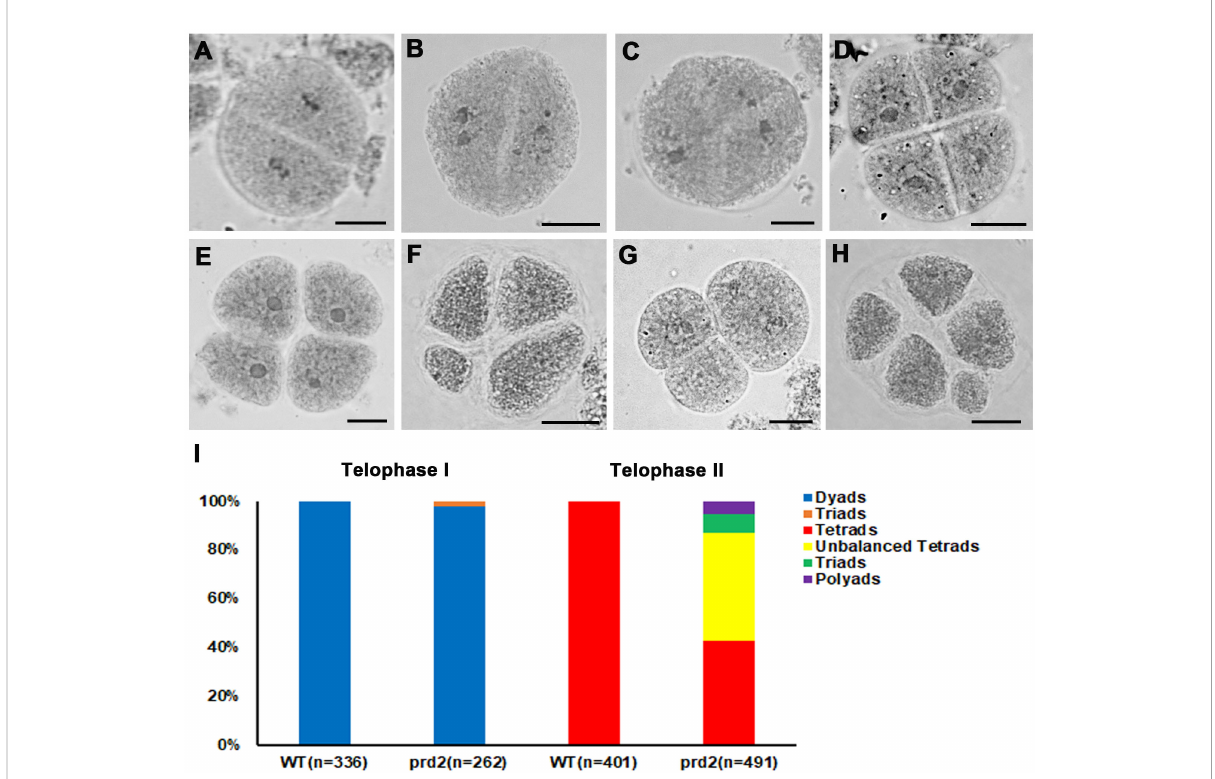
FIGURE 5 Meiotic products analysis of wild type and osprd2 mutant. (A – C) are telophase I stages; (D – H) are telophase II stages; (A, D) are wild type; (B, C, E – H) are osprd2 mutant. Bar=5 m